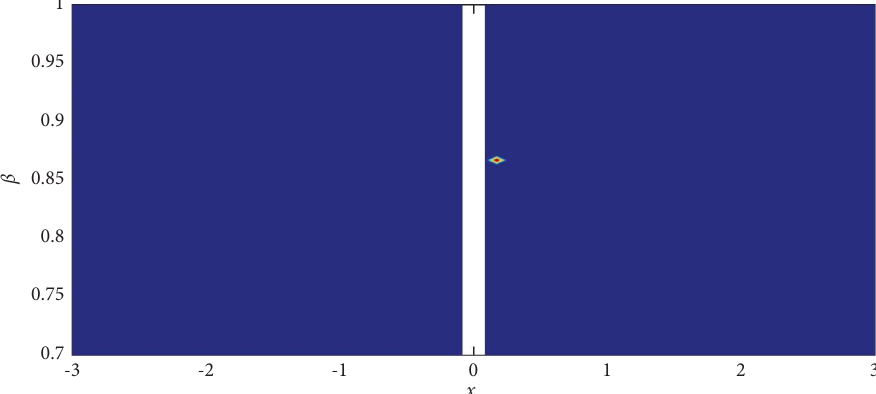
Figure 3: Convergence planes of frst-order FNR on f